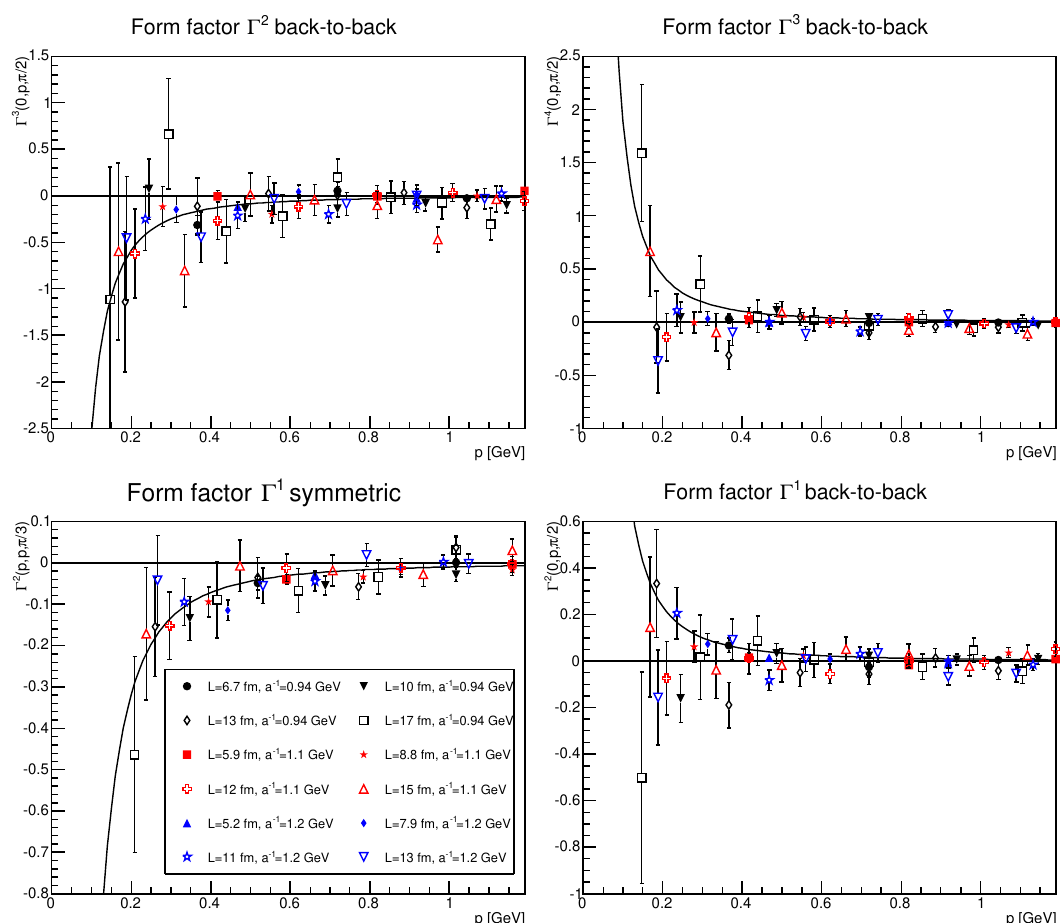
Figure 4: The non-tree-level form-factor of three-gluon vertex in three dimensions for the investigated momentum configurations. The symmetric case with only one non- trivially non-vanishing form factor is shown in the lower-left panel. The remainder are the three non-tree-level form factors in the back-to-back momentum configura- tion. The fits are discussed in the